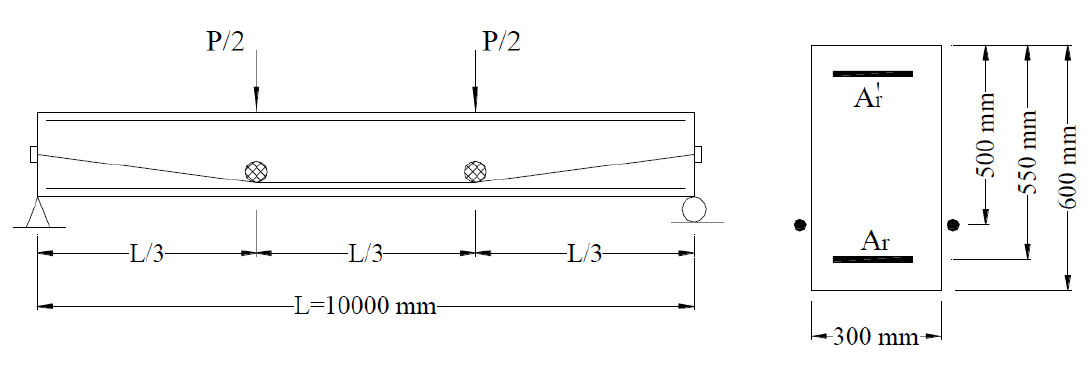
' A are the areas of tensile and r